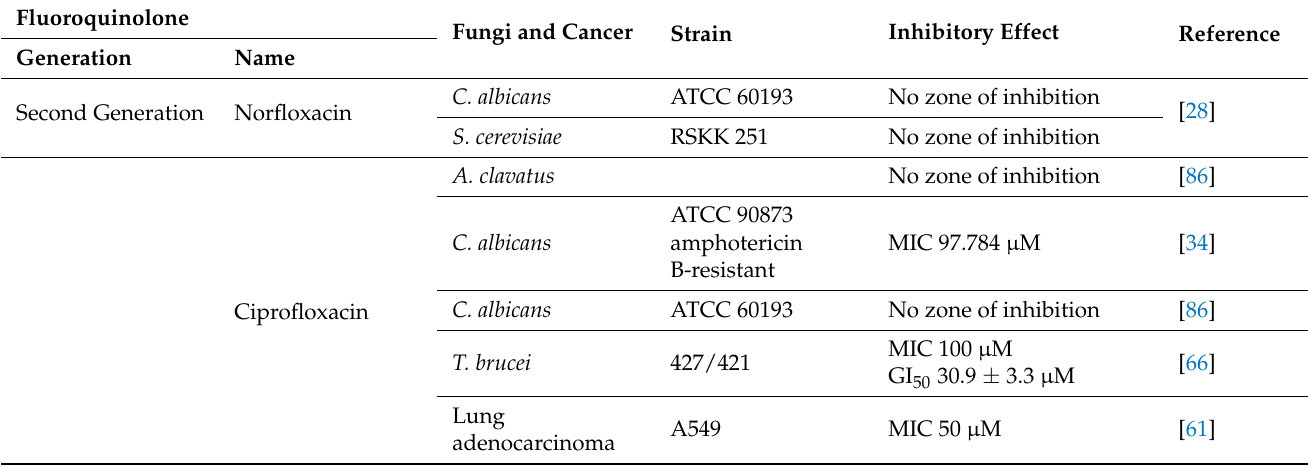
Table 6. Fluoroquinolones’ antifungal and anticancer